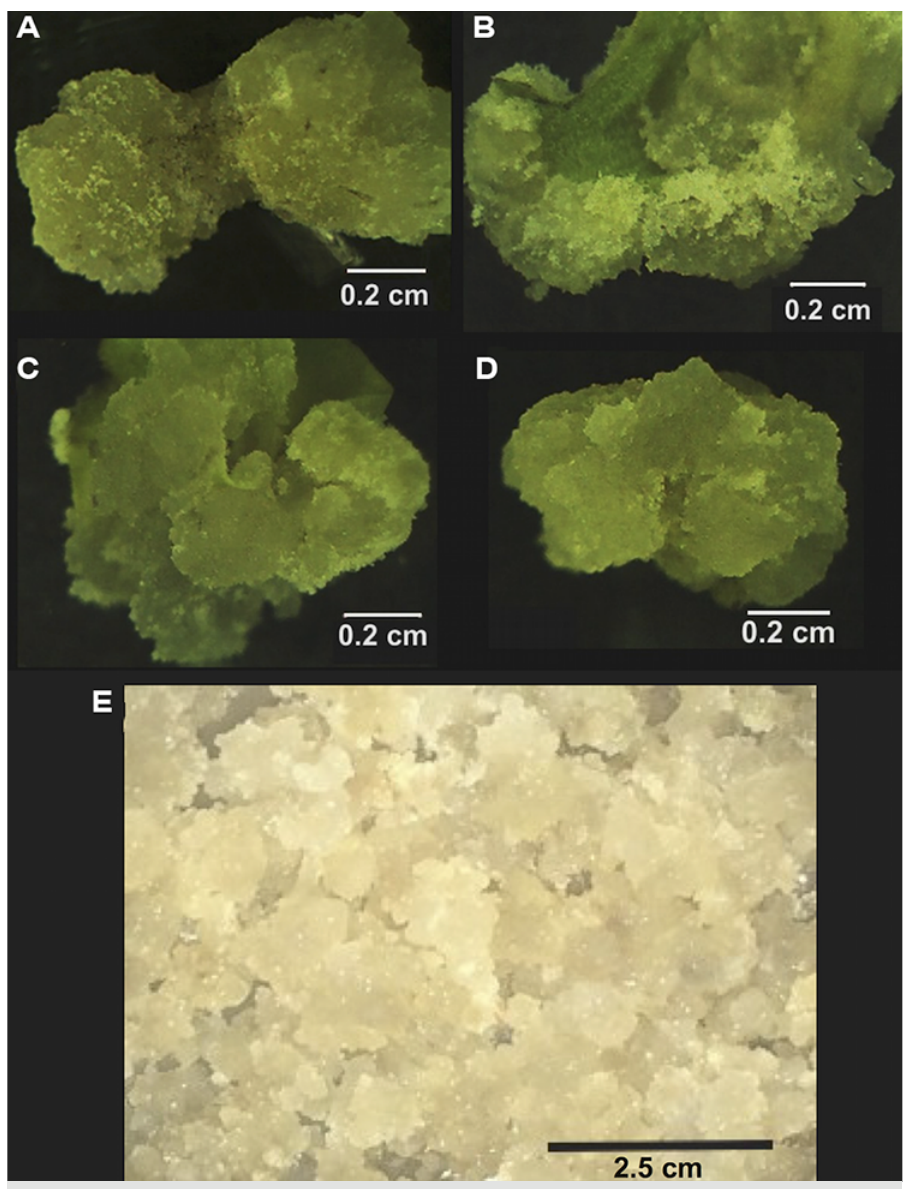
Fig. 1 Stereoscopic micrographs of callus from C. annuum ‘Serrano’. Induction after 2 weeks in explants excised from ( A ) hypocotyl, ( B ) cotyledonary leaf, ( C ) primary leaf, and ( D ) apex shown at ×10 magnification. ( E ) Subcultivated hypocotyl-derived callus, 3 weeks after transfer shown at ×1.0